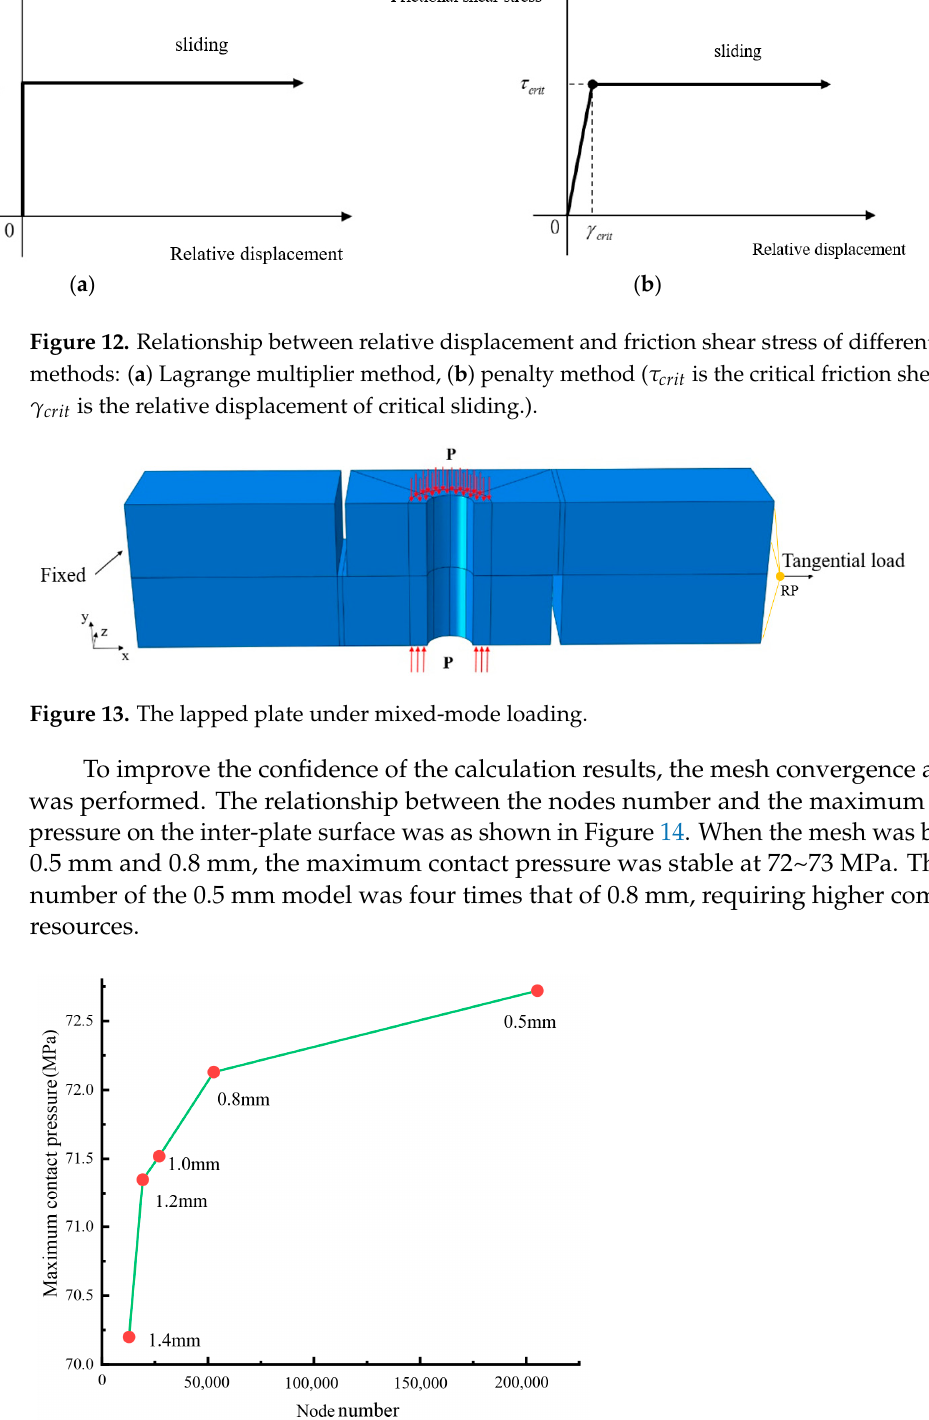
Figure 14. The mesh convergence curve.